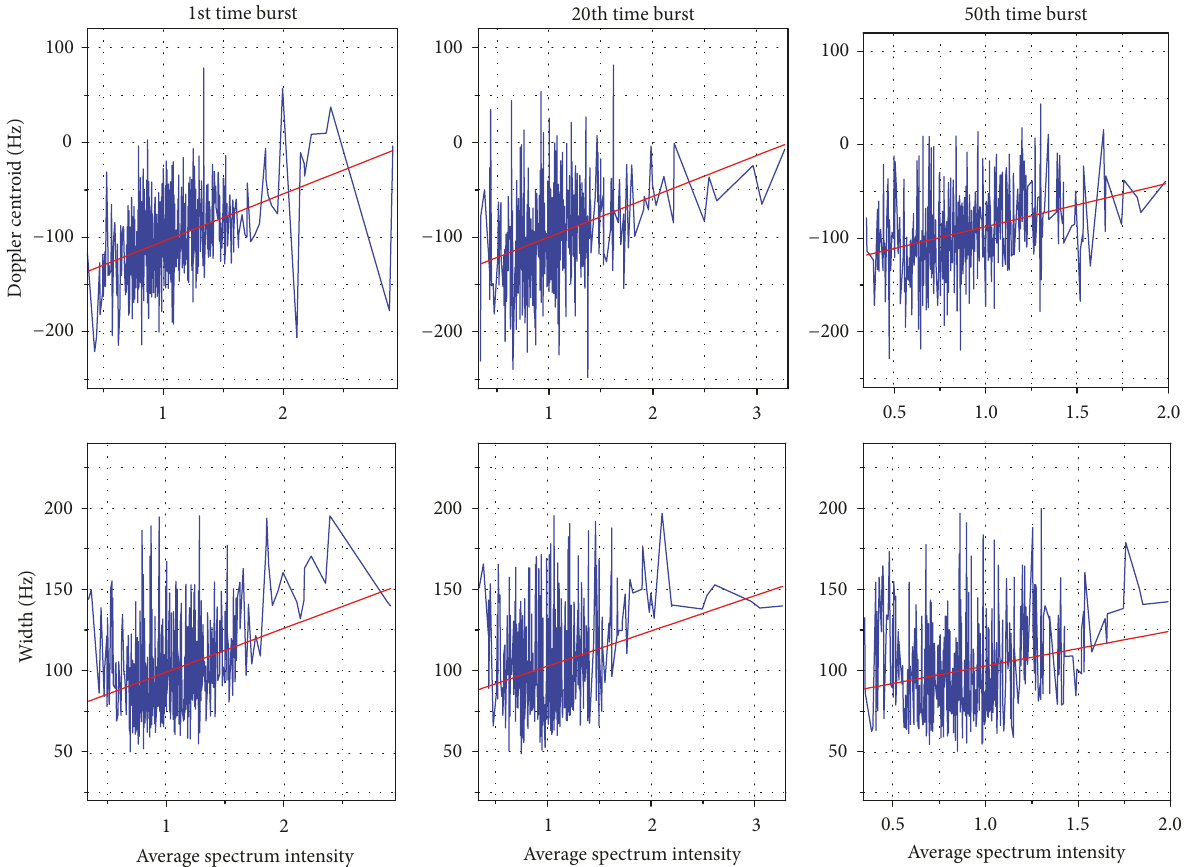
Figure 23: Spectra parameters versus intensity for the sum channel, with least-mean-square error straight-line fit: blue, data; red, model